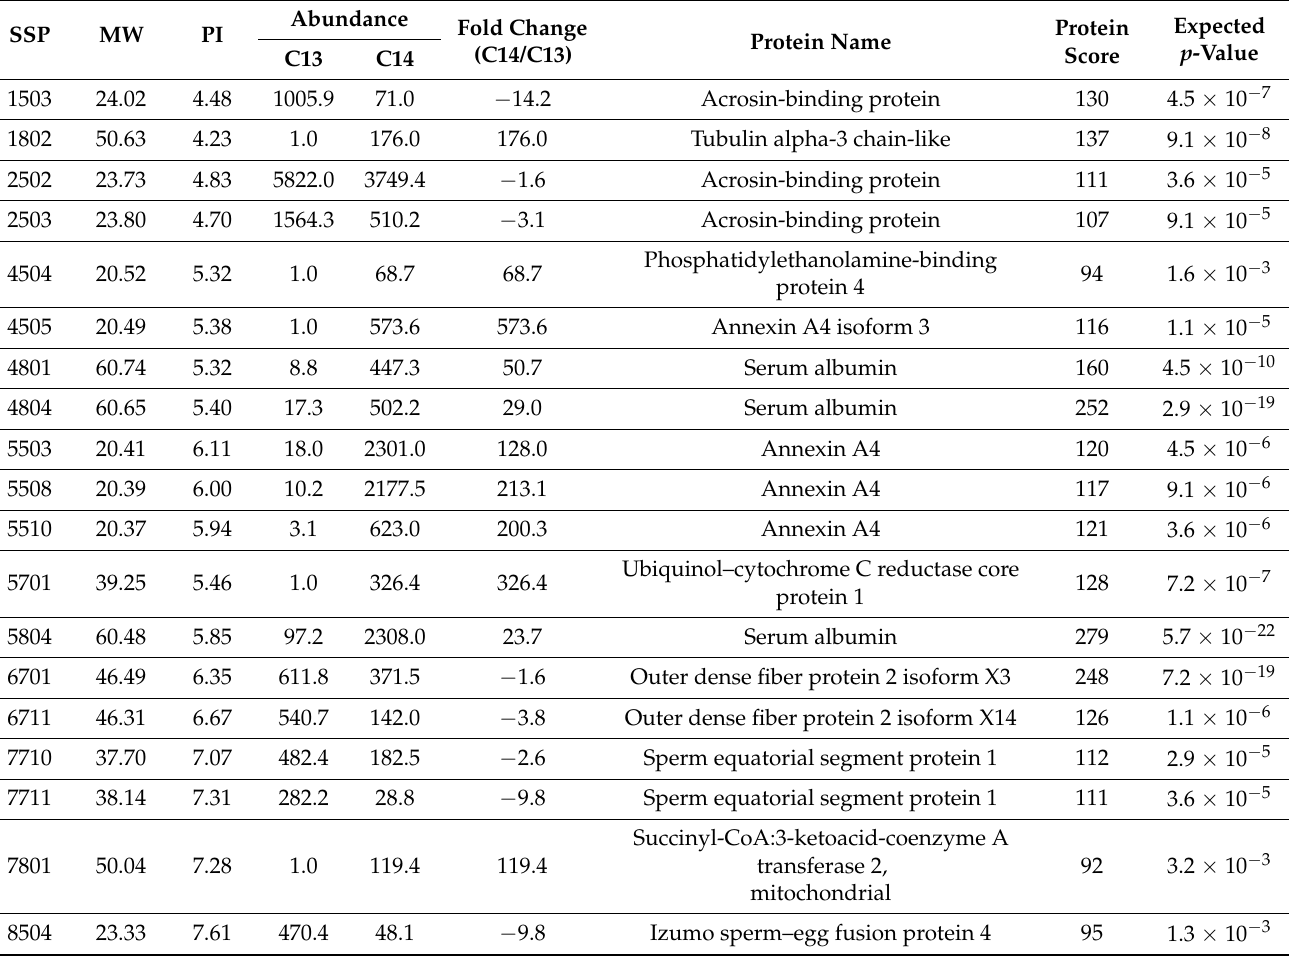
Table 2. Differentially expressed proteins (DEPs) in C14 sperm compared to C13